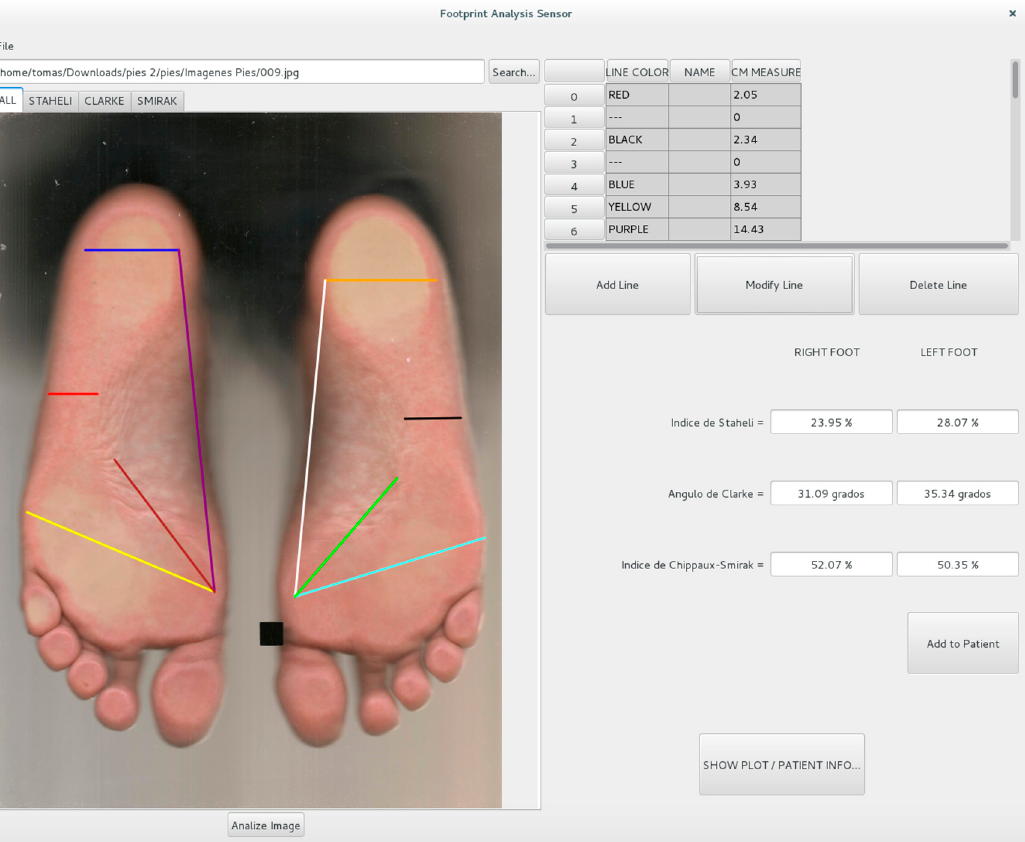
Figure 10. The graphical user interface of the footprint analysis sensor.